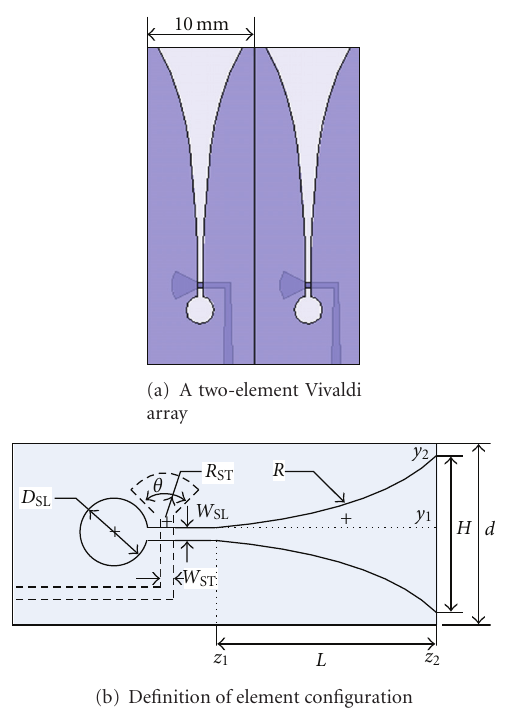
Figure 11: Schematic graph of Vivaldi antenna array.